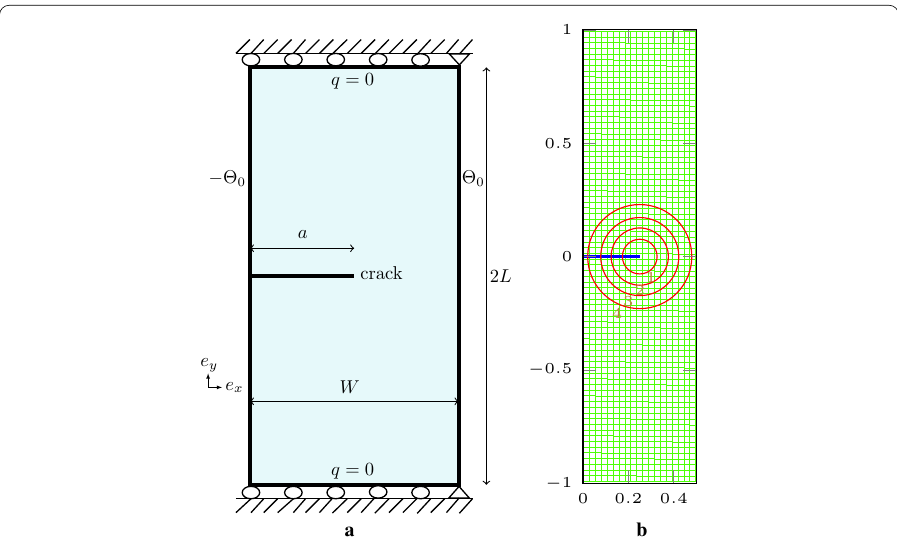
Fig. 17 Edge cracked strip under pure thermal load: a geometry and crack growth boundary conditions, b structured mesh used